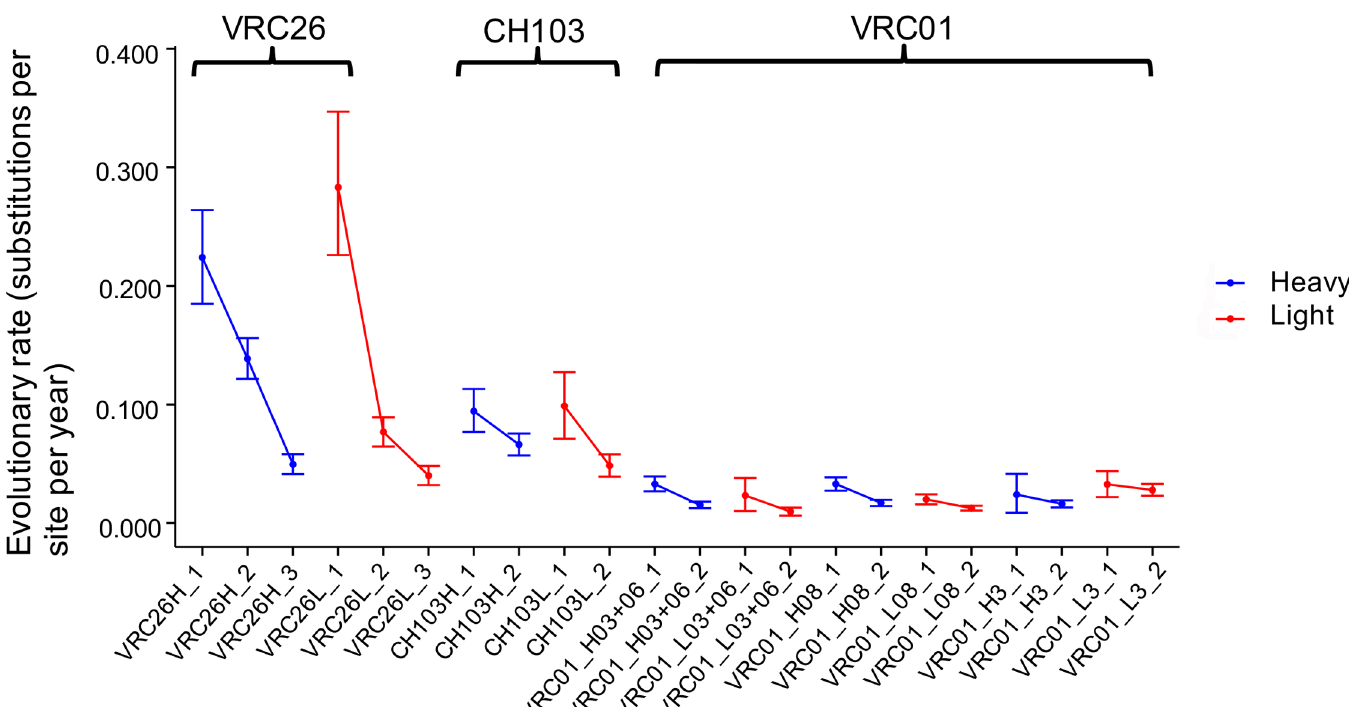
Fig 4. The evolutionary rates of the three antibody lineages decrease over time. The evolutionary rates for the stages of the three lineages were calculated using BEAST2. The mean evolutionary rates for the VRC26, CH103, and VRC01 lineages decreased about 80%, 45%, and 35% respectively over their study periods. However, the observed evolutionary rate decrease is not statistically significant for clade 08 light chain, clade H3, and L3. Each stage is labeled with the format of lineage name, chain name, and stage. Because clades of the VRC01 lineage showed more than 30% divergence from each other, we chose four representative clades (03+06, 08, H3, and L3) and calculated their evolutionary rates separately. The mean and 95% HPD are shown for each stage. Stages from the same chain of a lineage are connected to reveal longitudinal trends. The evolutionary rates of heavy chains and light chains are colored blue and red